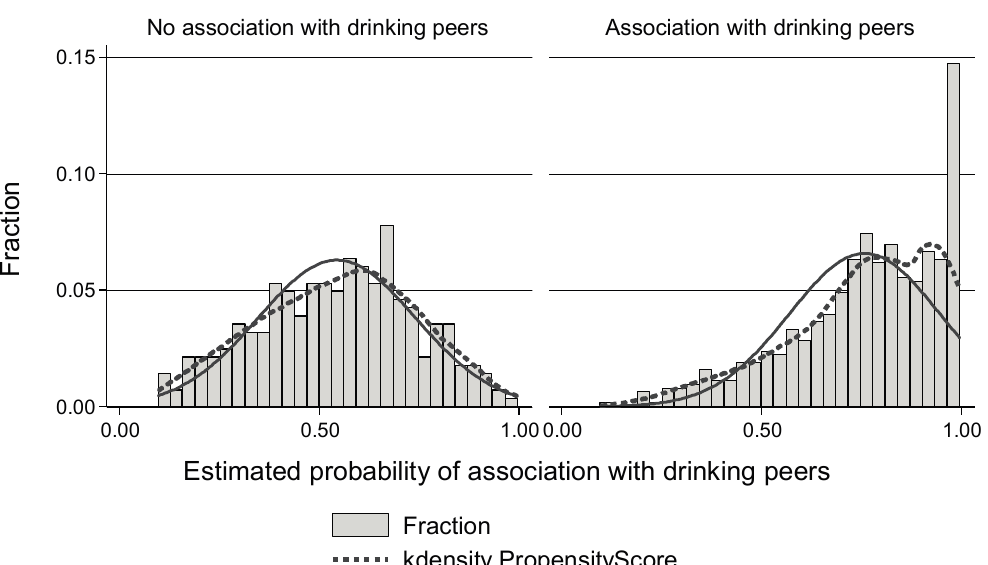
Figure 1. Histogram of Estimated Propensity Score by Association with Peer Drinkers ( N =